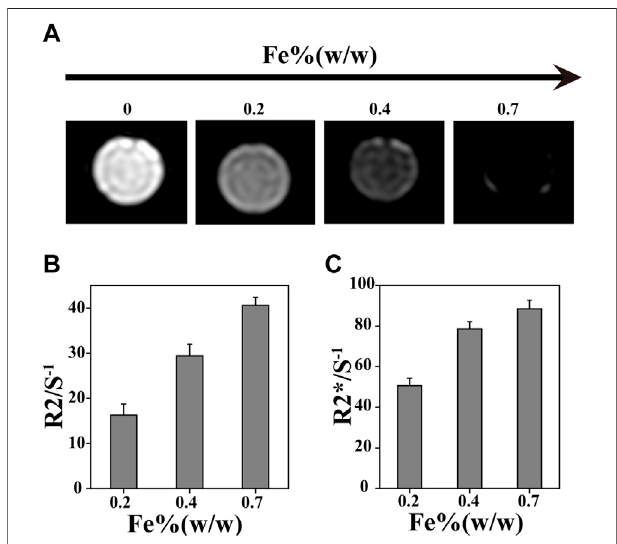
FIGURE 4 | Cytocompatibility of hydrogels. (A) Live/dead staining of BMSCs cultured with hydrogel extracts; (B) cell viability of BMSCs cultured with SMNP with different Fe content; (C) migration depth of SMNP-KGN with different Fe (III) content; (D) cell viability of GelMA/ODex/SMNP and GelMA/ODex/SMNP-KGN hydrogel.